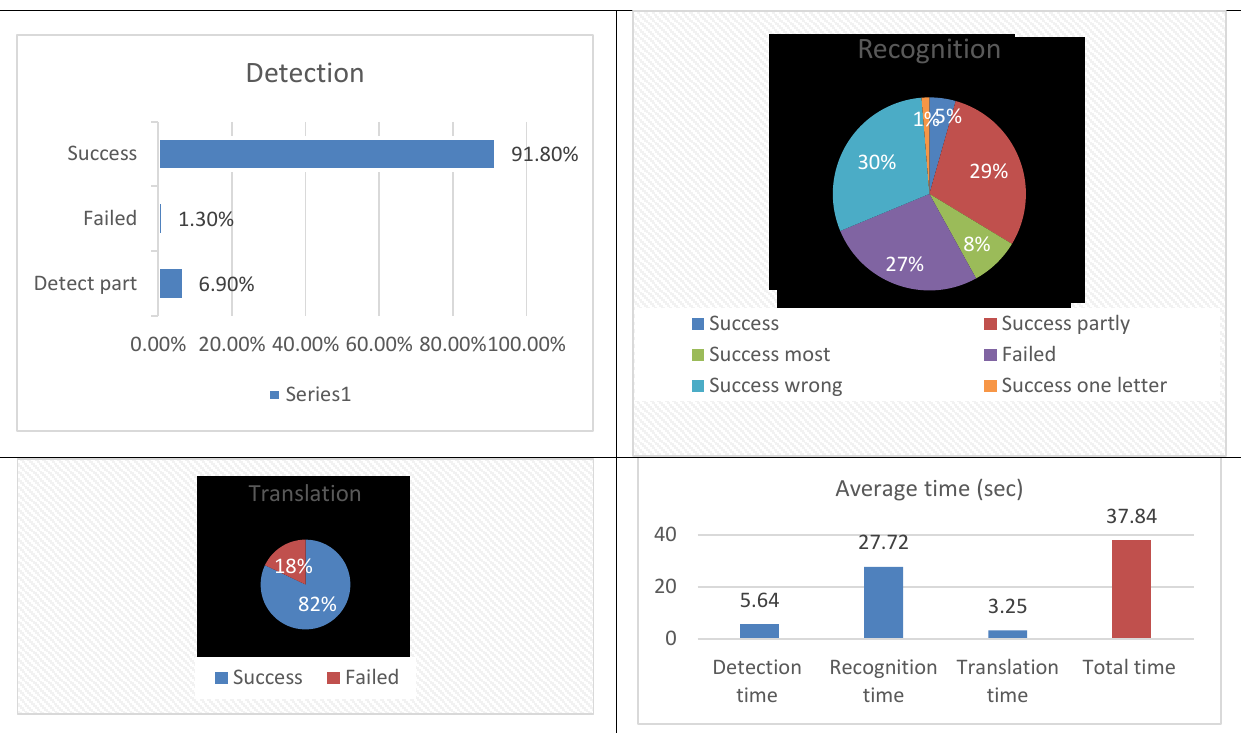
Fig. 5. Formed dataset testing results